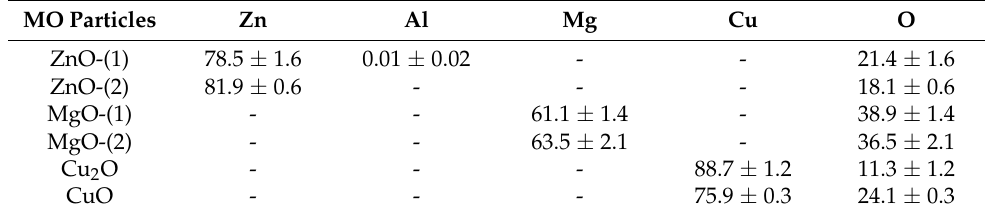
Table 1. Atomic compositions of metal oxide (MO) particles.